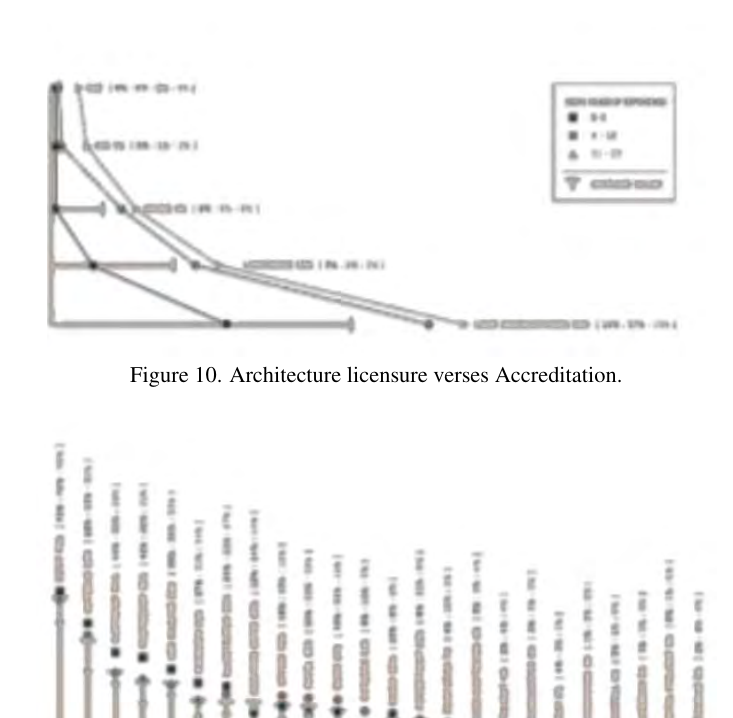
Figure 9. Top skills –Required by Architecture Consultant members on LinkedIn